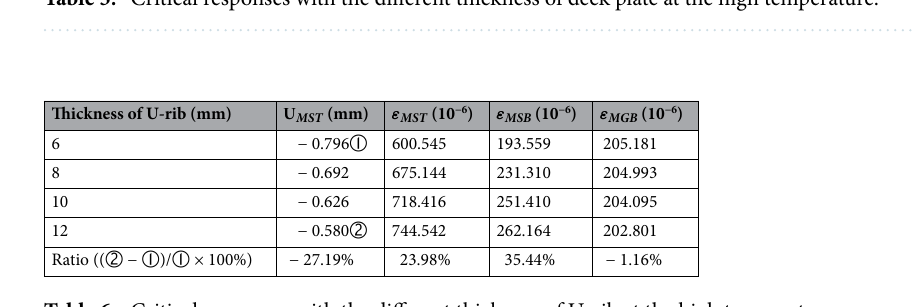
Table 5. Critical responses with the different thickness of deck plate at the high temperature.